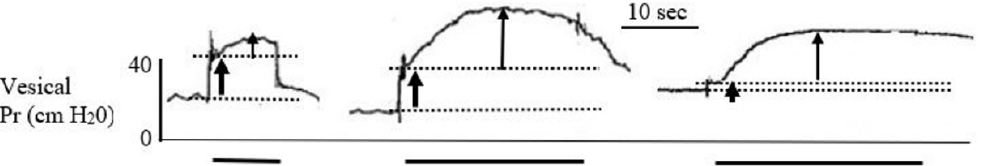
Figure 4. Bladder pressure responses to DBWS from the three minipigs after general anesthesia and using the single-current protocol of 60 mA, 40 Hz and 10–20 s stimulation (PO day 9). The pressure records demonstrate the initial abdominal wall contraction as a sharp rise in pressure, marked between the two guidelines by the lower thick arrow. The vesical wall contractions are marked by the narrow upper arrow. The continuous stimulation period is marked below the records by the thick solid lines.